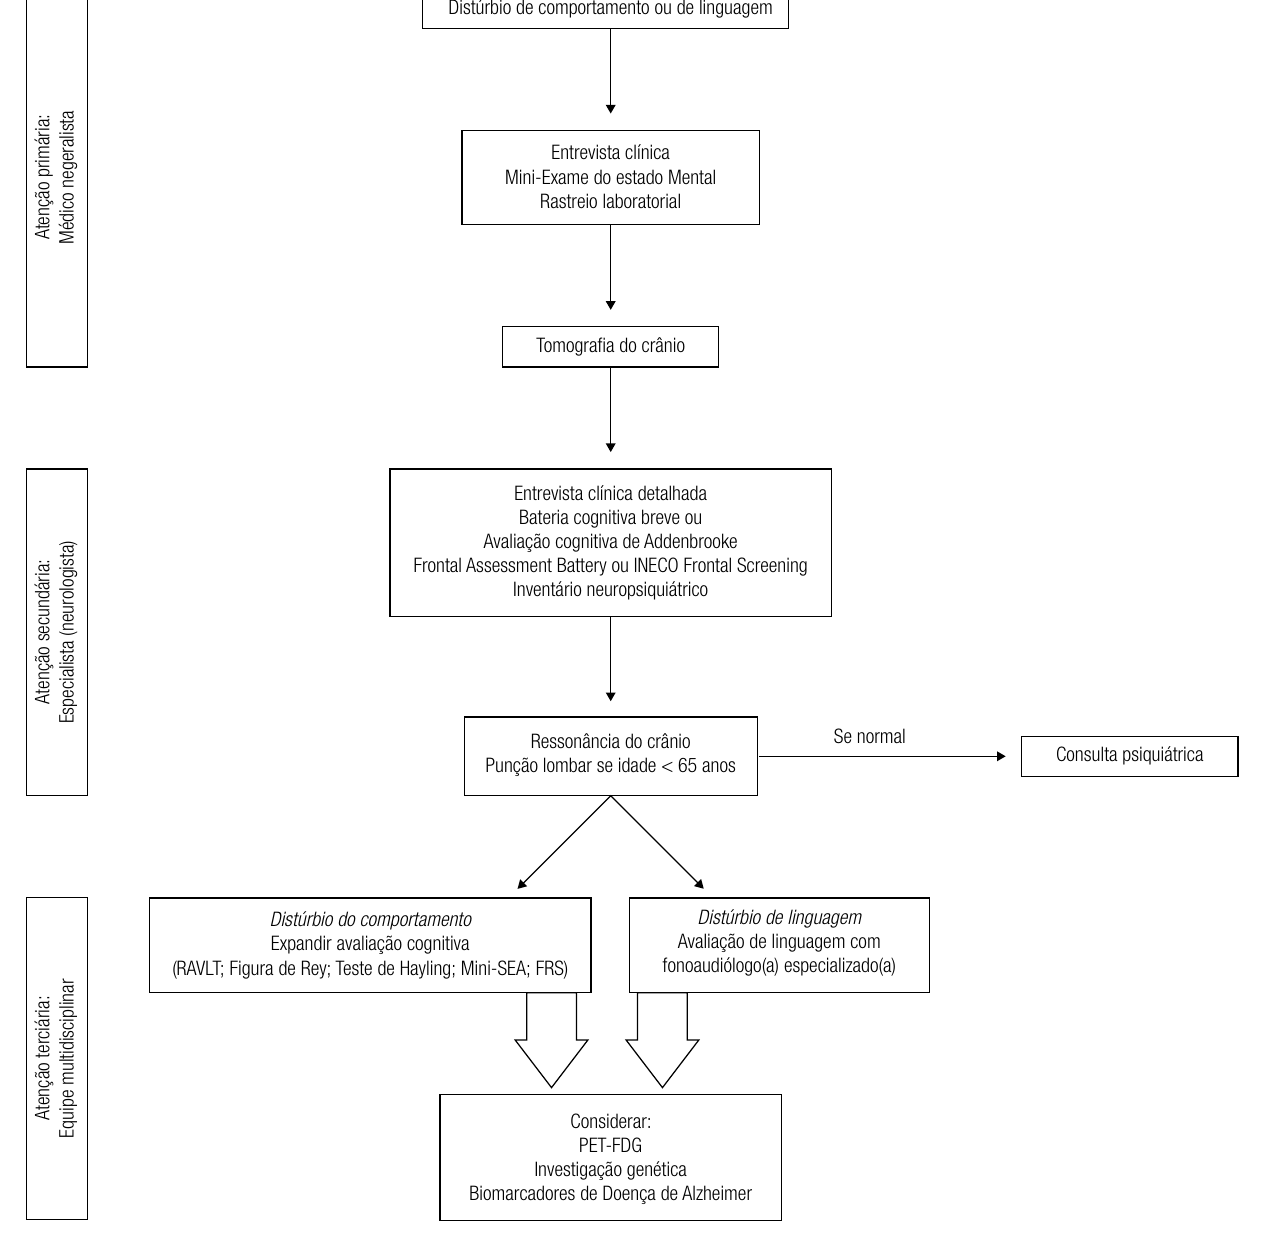
Figura 1. Abordagem da Demência